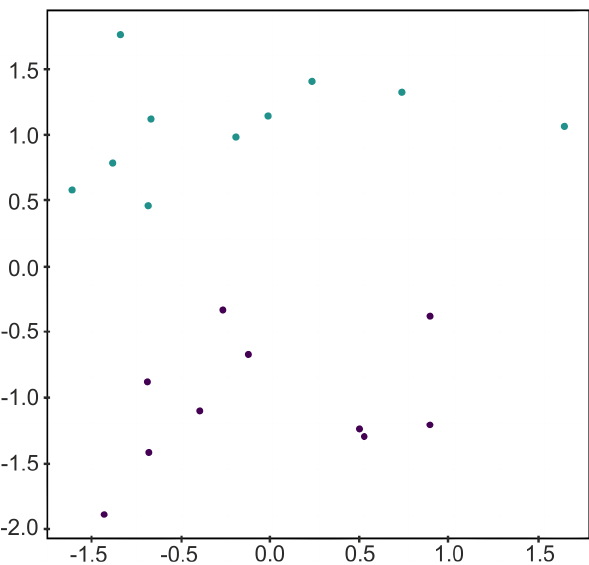
Figure 1. A toy example of a two-dimensional data set for binary classification generated using the scikit-learn package implementation of [23].